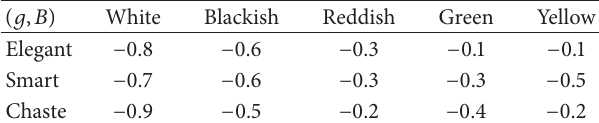
Table 10: Tabular representation of (𝑔,𝐵)